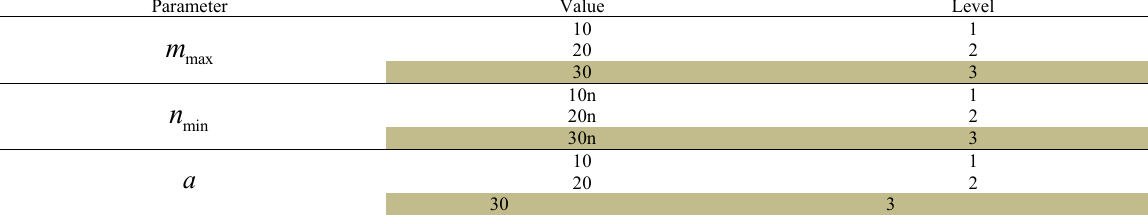
Parameters of the proposed Mat-VNS algorithm and their levels